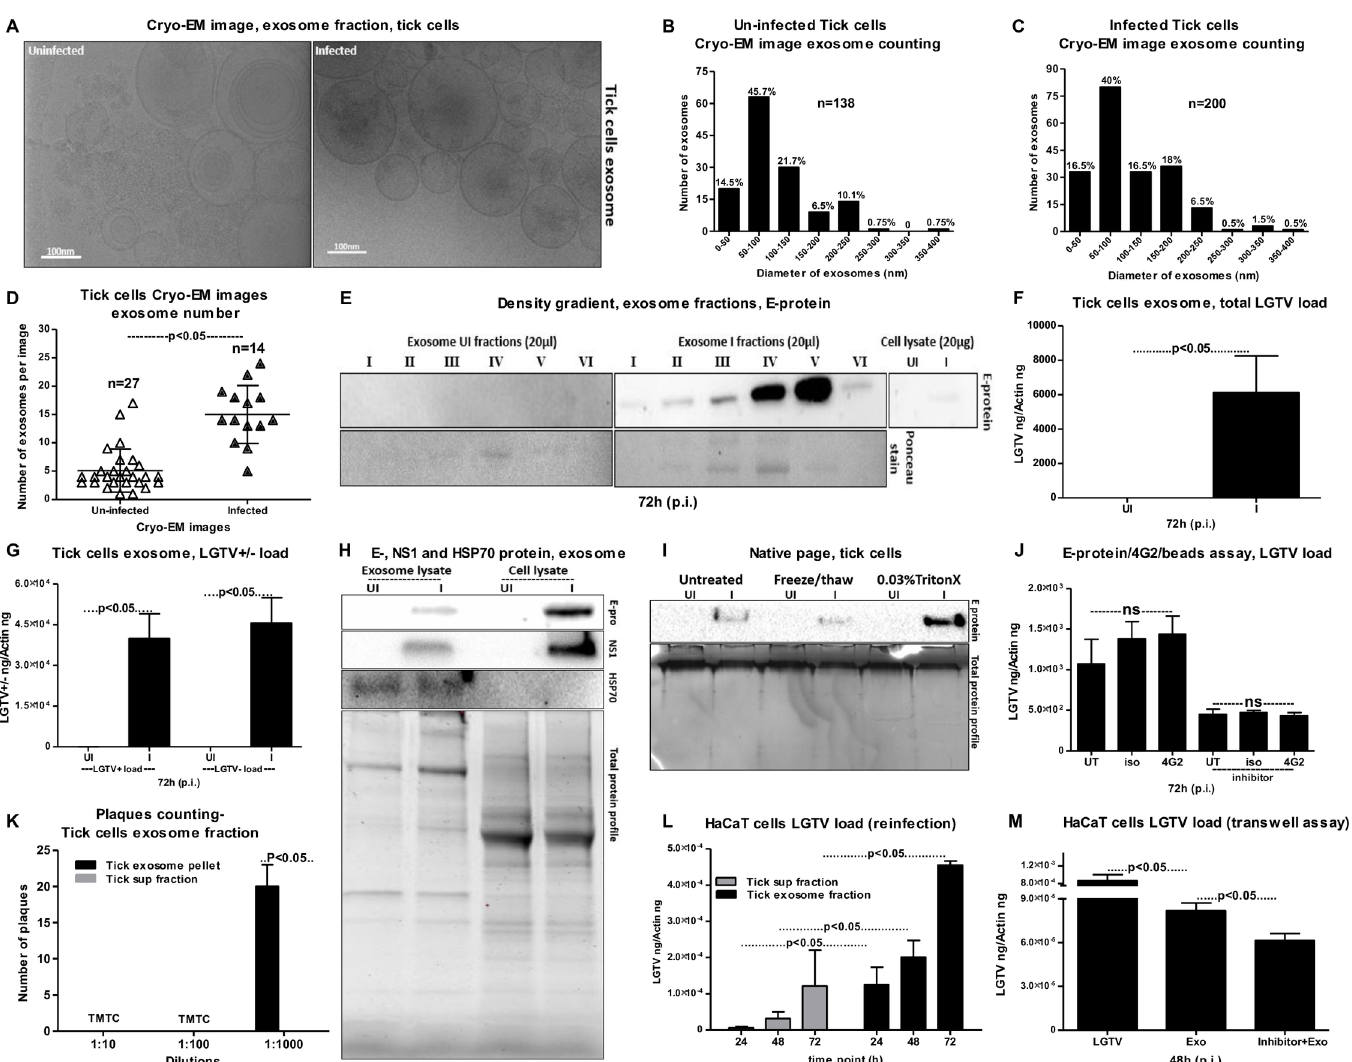
Fig 1. Arthropod exosomes mediate transmission of infectious LGTV RNA and proteins from tick to human cells. (A) Cryo-EM images showing exosomesisolated from uninfectedand LGTV-infected (MOI 1; 72 h p.i.), ISE6 tick cells. Scale bar indicates 100nm. Quantification of diameteror sizes for heterogenous populationof exosomes from uninfected(B) or LGTV- infected (C) tick cell-derivedexosomes. Number of exosomes analyzedwere n = 138 (uninfected) and n = 200 (infected) groups. (D) Comparison of exosome numbers per cryo-EM image from uninfected(n = 27) and infected (n = 14) groups is shown. (E) DG-Exos showingpresence of LGTV envelope[E]-protein in fractions 1–6. QRT-PCR analysisshowingtotal LGTV loads (F) and levels of LGTV positive-sense strand or negative-sense strand (G) in exosomesisolated from tick cells at 72 h (p.i.), Uninfected cells serve as control. LGTV transcript levels were normalized to tick beta-actin. (H) Immunoblotting analysisshowingdetection of LGTV E- glycoprotein in exosome fraction and total lysates from whole cells preparedfrom uninfected(UI) or infected (I) tick cells at 72 h (p.i.). ImmunoblotdetectingNS1 in both tick-cell derived exosomesand total cell lysates using monoclonal anti-Langat virus NS1 protein from LGTV-infected (MOI 1; 72 h p.i.) is also shown. HSP70 levels indicateenrichment of arthropodexosomal marker in exosome fractions. Uninfectedsamples and total protein profiles serve as controls. Tick cells (5 x 10 6 ) were infected with 1 MOI of LGTV in both QRT-PCR and immunoblotting analysis. I) Native-PAGE followedby immunoblotting analysisshowingpresenceof E-proteinfrom LGTV-infected (MOI 1; 72 h p.i.) or uninfectedtick cell-derivedexosomestreated with Triton-X-100 (0.03%), or freeze-thaw cycles (3 times freezing at -80˚C for 1 h each cycle) or untreatedsamplesheld on ice. Coomassie stainedgel showingtotal protein profiles serve as loadingcontrol (I). (J) Antibody-beads bindingassay performed on LGTV infected (MOI 1) tick cell-derivedexosomes(collected from tick cells either untreated or treated with GW4869; 5 μ M, exosome inhibitor)showingno differences in Langat-Eprotein loads between4G2 or isotype and untreatedsamples. (K) Quantitative assessment of numberof plaquesin exosomal and supernatant fractions is shown. TMTC indicates“too many to count”. (L) Viral re-infection kinetics as determined by the presence of total LGTV loads in HaCaT cells (1 x 10 5 cells) at different time points treated with exosomes (20 μ l) or supernatantfractions (400 μ l) preparedfrom 72 h p.i. LGTV-infected tick cells are shown. (M) Viral loads at 48 h p.i. was determined by the presenceof LGTV in a transwellassay performed with 1 x 10 5 tick cells (in upper chamber) or 1 x 10 5 HaCaT cells (in lower chamber) treated with tick exosome fraction (20 μ l, in upper chamber)for 4 h in the presence or absenceof 5 μ M exosome inhibitorGW4869. Tick cells infected with LGTV laboratorystocks were used as controls. LGTV transcript levels were normalized to humanbeta-actin in (L) and (M). P value determinedby Student’s two-tail t test is shown. Representative data is shown from three independentexperiments.